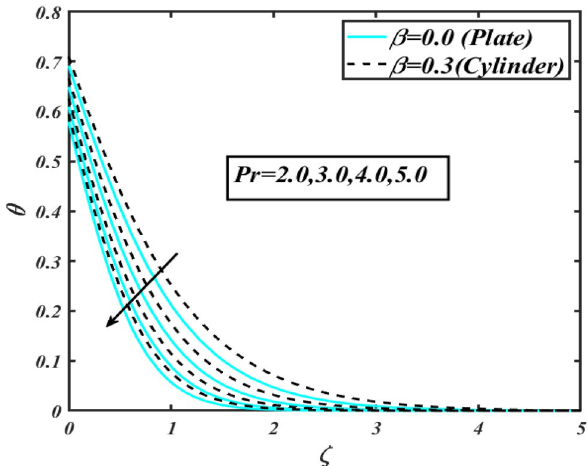
Figure 12. Profile of θ for Pr .